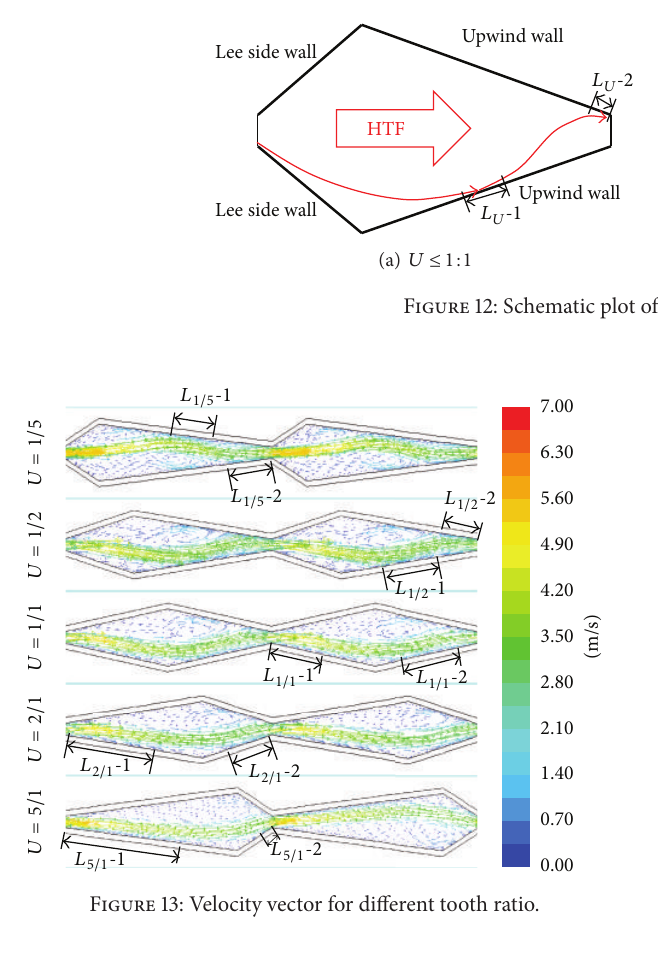
Figure 14: The proportion of 𝑄 𝐿 in 𝑄 as a function of time among the heat exchangers with different tooth